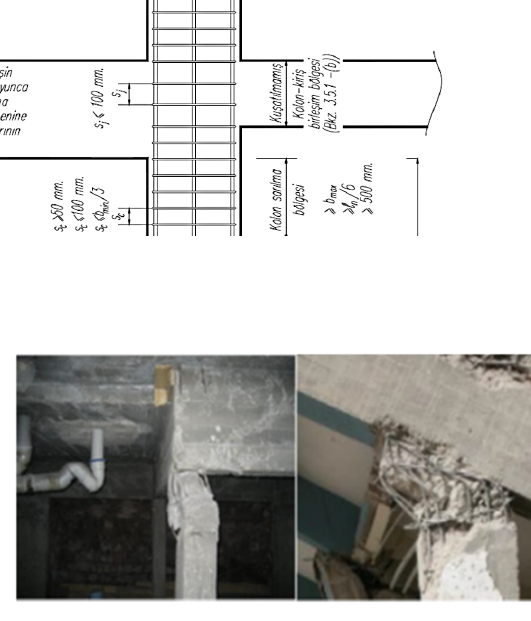
Figure 18. Examples of strong-beam–weak-column damage.